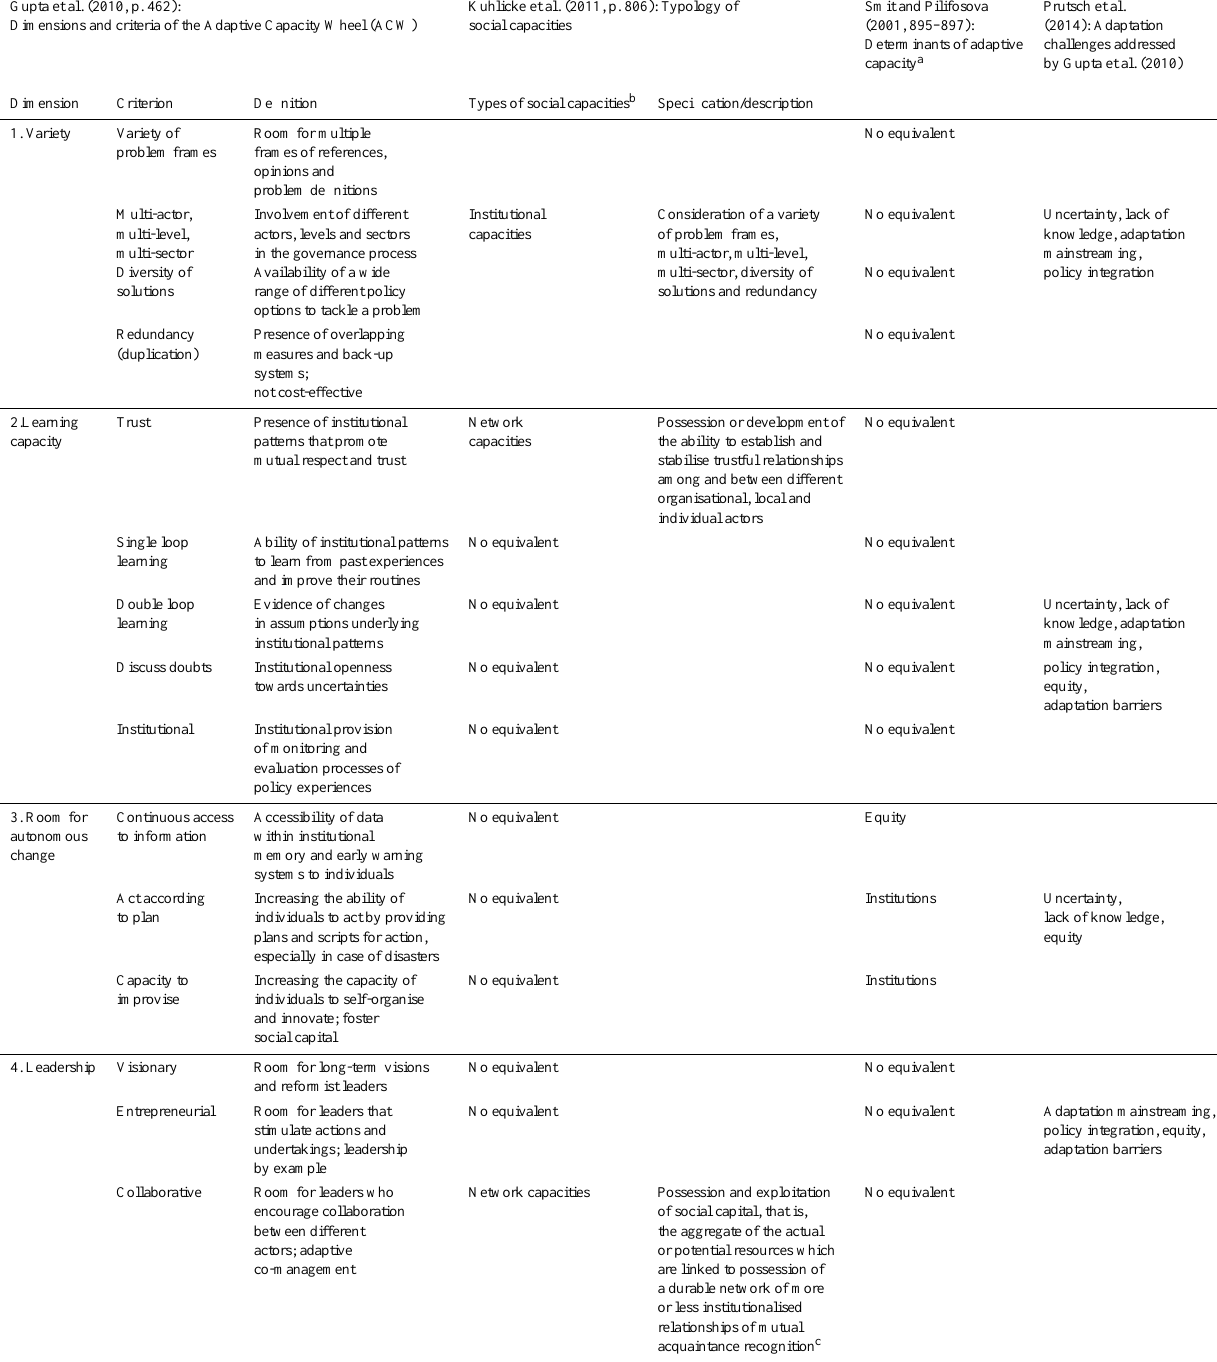
Table 1. Comparison of Adaptive Capacity Wheel by Gupta et al. (2010) with other frameworks of adaptive or social capacities. Gupta et al. (2010, p. 462): Kuhlicke et al. (2011, p. 806): Typology of Smit and Pilifosova Prutsch et al. Dimensions and criteria of the Adaptive Capacity Wheel (ACW) social capacities (2001, 895–897): (2014): Adaptation